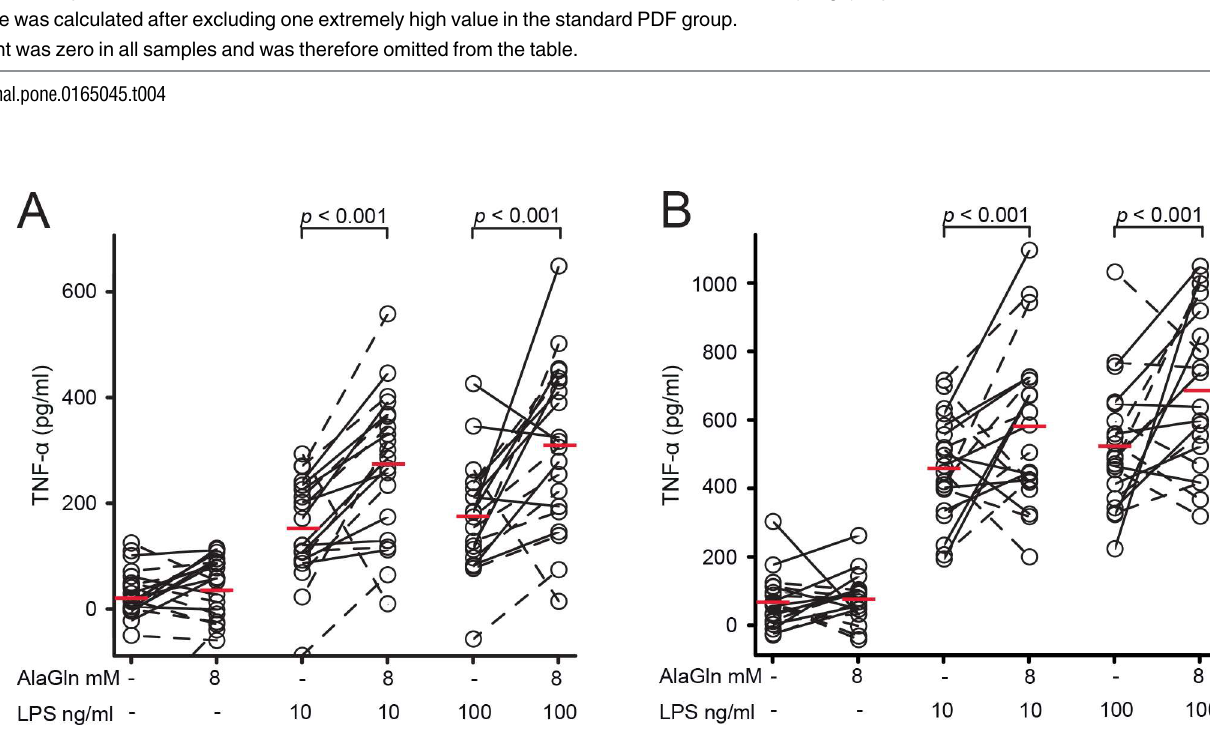
Fig 4. Lipopolysaccharide (LPS)-stimulated release of tumor necrosis factor alpha (TNF- α ) by heterologous normal human peripheral blood mononuclear cells (PBMC) following a 4 h ex-vivo exposure to PD effluents obtained from the PET of patients treated with standard PDF or AlaGln-supplemented PDF. In panel A exposure to effluent mixed 1:1 with fresh PDF (representingthe situation of the “early dwell”) is shown. In panel B exposure to pure effluent (representing the situation of the “late dwell”) is shown. Each data point represents the mean value of TNF- α releaseby PBMC from 4 healthy donors exposed to each PET effluent (n = 20 in each group). The left part of the figures represents the control with exposure to patient effluents without stimulation by LPS (0 ng/ml).